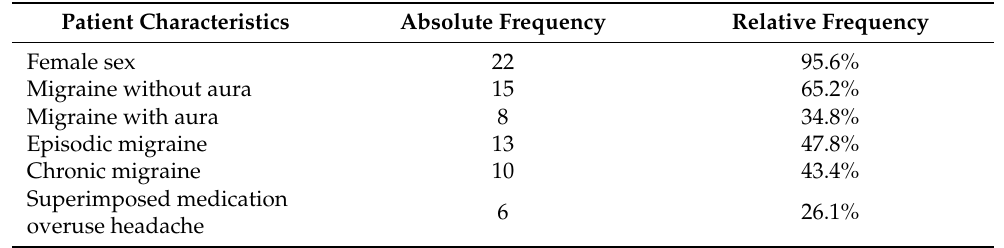
Table 1. Patients’ clinical characteristics.